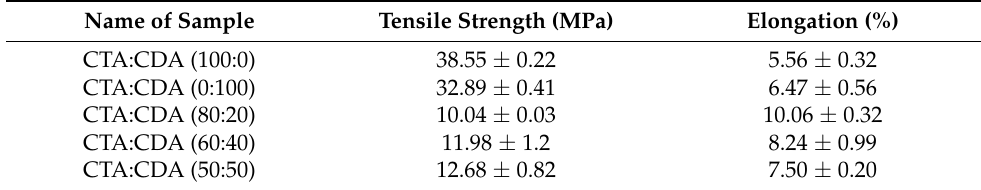
Table 2. Comparison of mechanical performance.